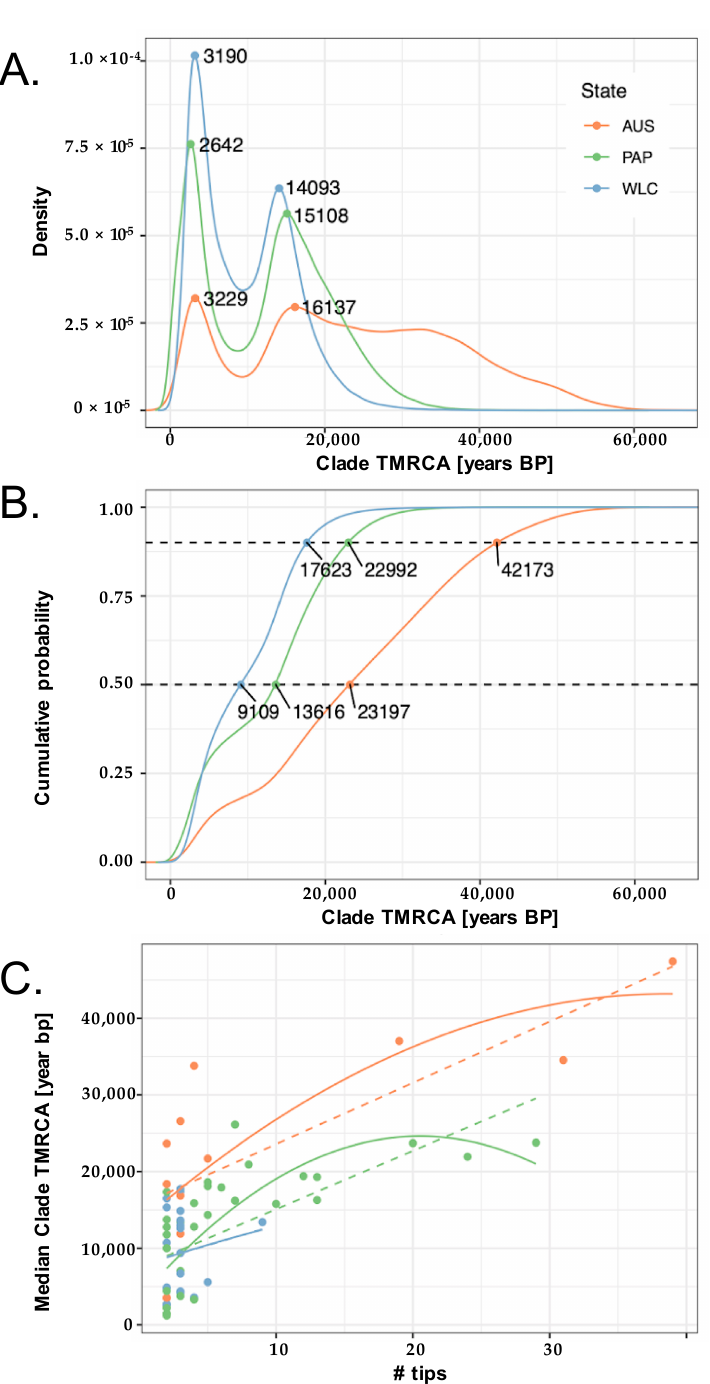
Figure 4. Properties of aggregated TMRCAs across Wallacea, New Guinea, and Australia. Probability distributions (PDF; ( A )) and cumulative distributions (CDF; ( B )) for the TMRCAs aggregated across all monophyletic clades in each region (see key in ( A )). TMRCAs for the 50th and 90th percentiles are indicated by the lower and upper dashed lines, respectively, in ( B ). TMRCAs were deeper on average for Australia, even after controlling for the number of tips (samples) in the clade ( C ). Linear and quadratic regression fits are shown as dashed and solid lines, respectively.